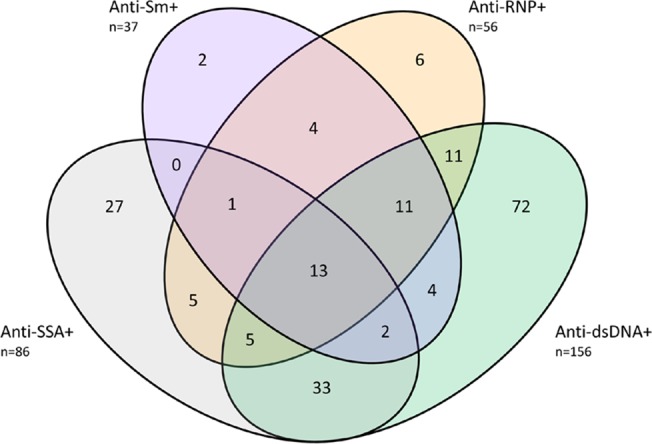
Autoantibody distribution of the study participants (n = 326).